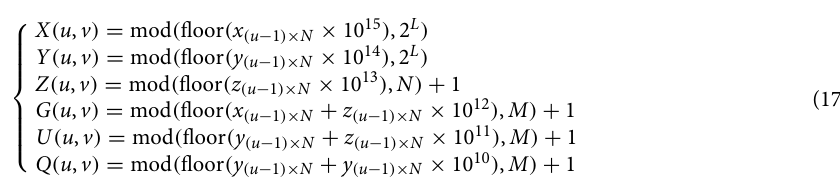
x 3 plane. ( b ) When − k ( 3 ) = 3 , the circuit simulation diagram of the =